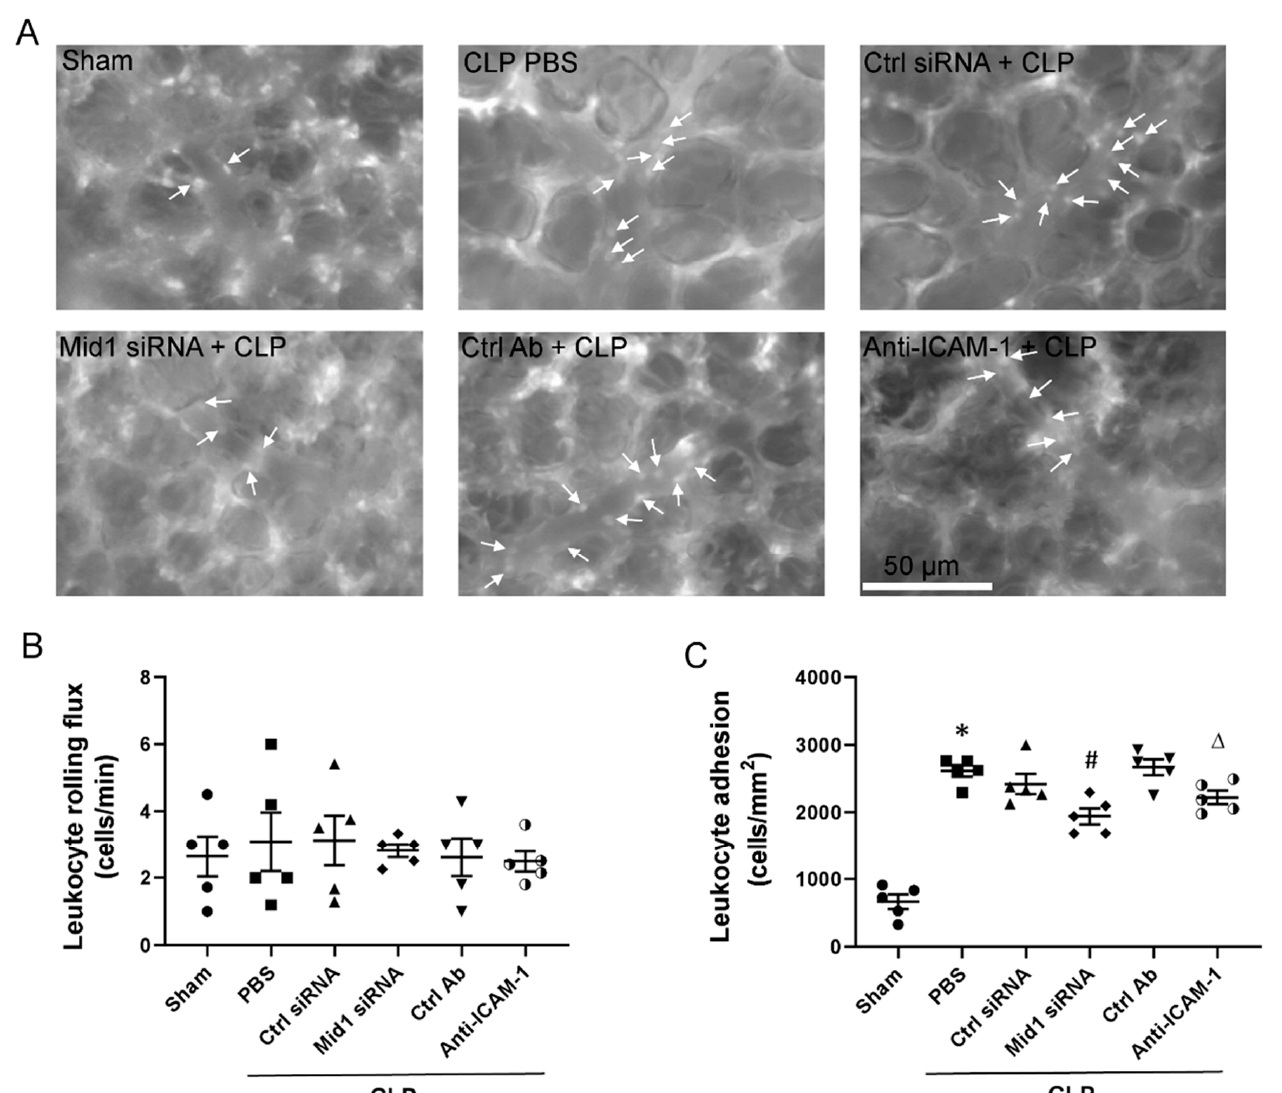
Figure 3. Leukocyte recruitment in vivo. ( A ) Representative images showing leukocytes adhesion to lung post-capillary venules. Scale bars = 50 µm. Leukocyte ( B ) rolling flux and ( C ) adhesion in mouse lung tissues 4 h after CLP induction; for sham group, animals underwent sham procedure as described in method. Animals were pretreated with negative control siRNA, Mid1 siRNA, anti- ICAM-1 and an isotype matched control antibody as described in the Materials and Methods section. Control animals were injected with PBS. Data are mean ± SEM and n = 5. * p < 0.05 vs. Sham, # p < 0.05 vs. Control siRNA + CLP, ∆ p < 0.05 vs. Control antibody + CLP.